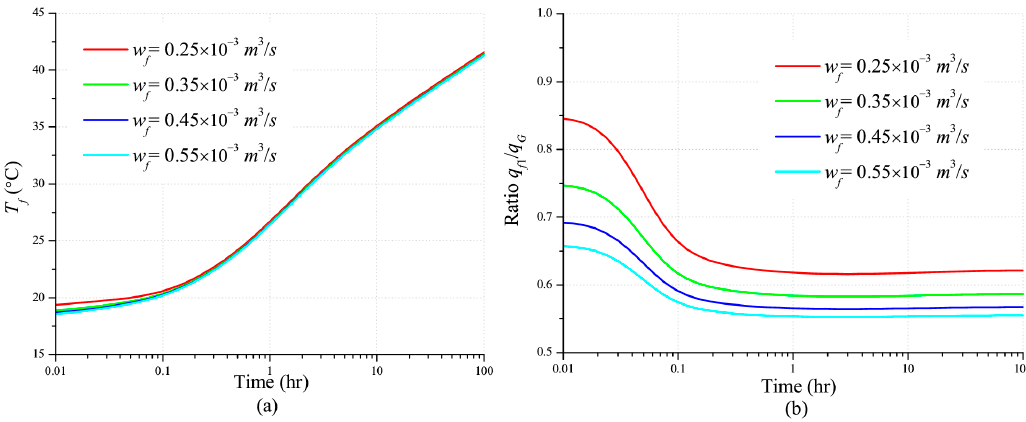
Figure 4. Thermal response plots of the U-tube with different flow rates: ( a ) average temperature of the fluid; and ( b ) ratio of the heat rate of the descending leg.